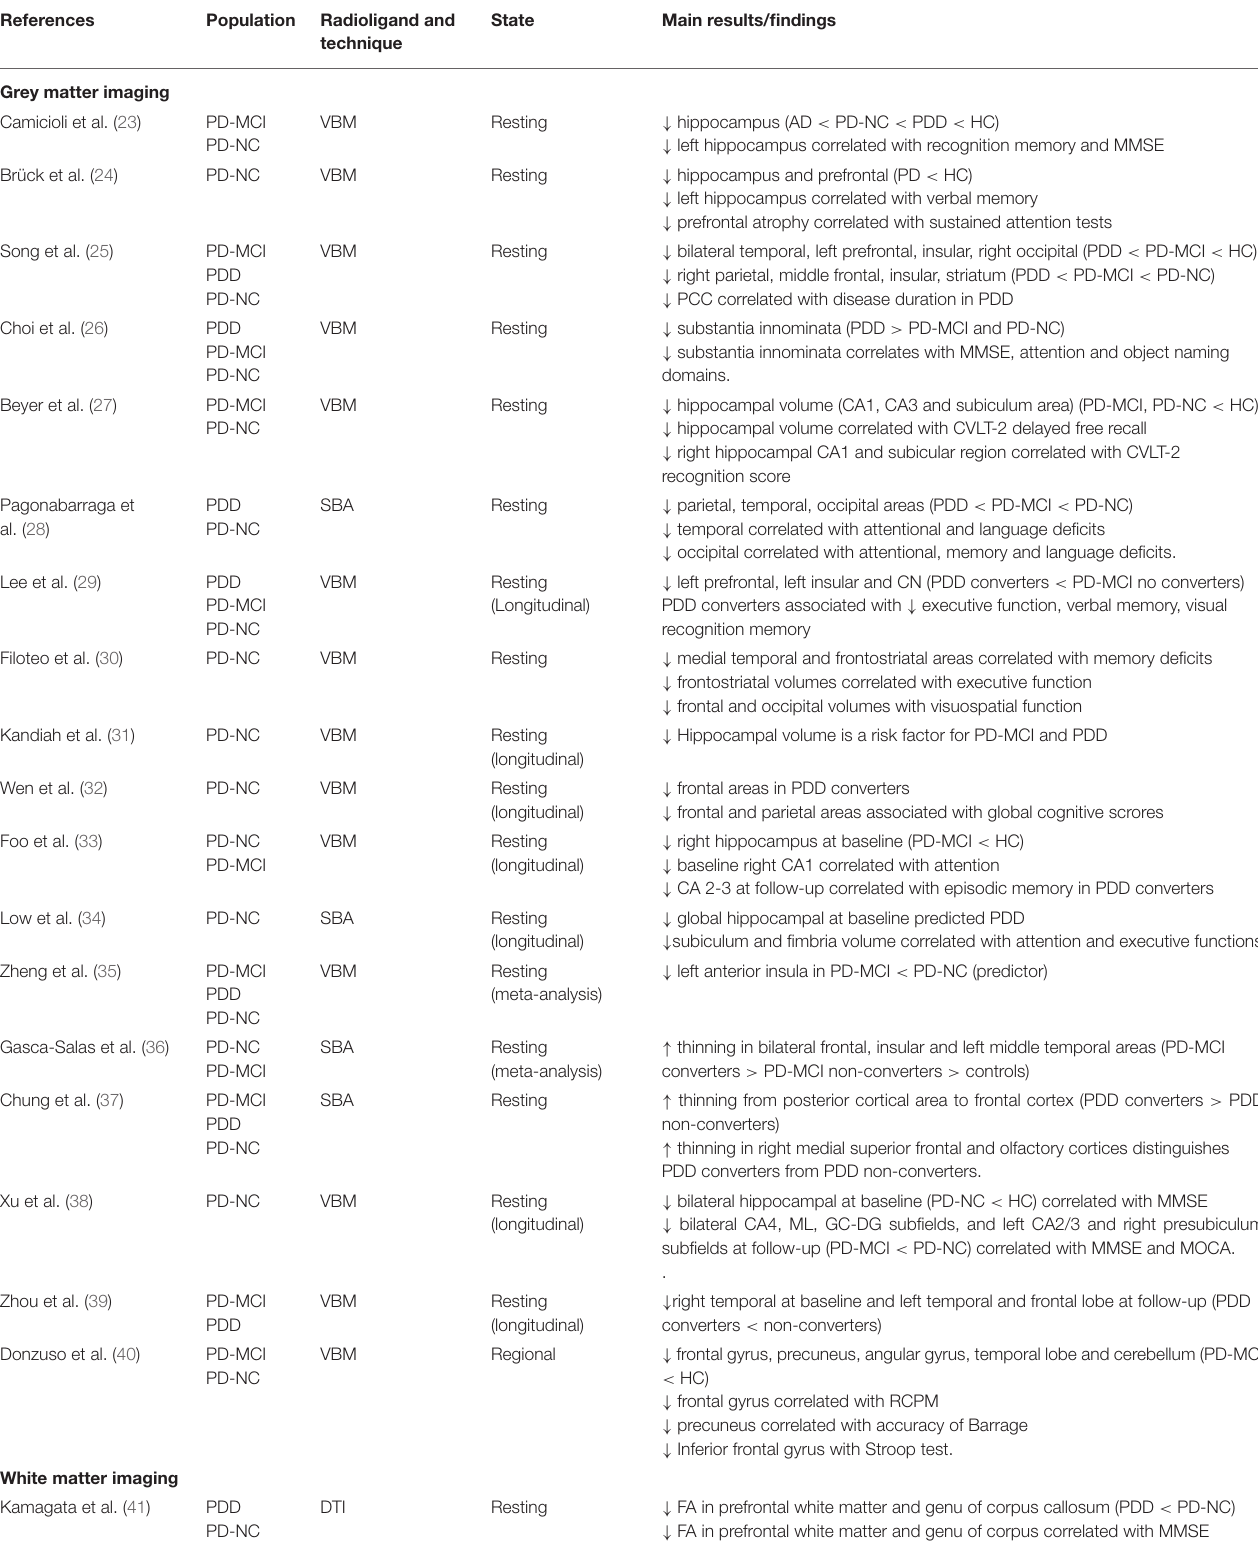
TABLE 1 | Magnetic resonance imaging studies of cognitive impairment or dementia in Parkinson’s disease.